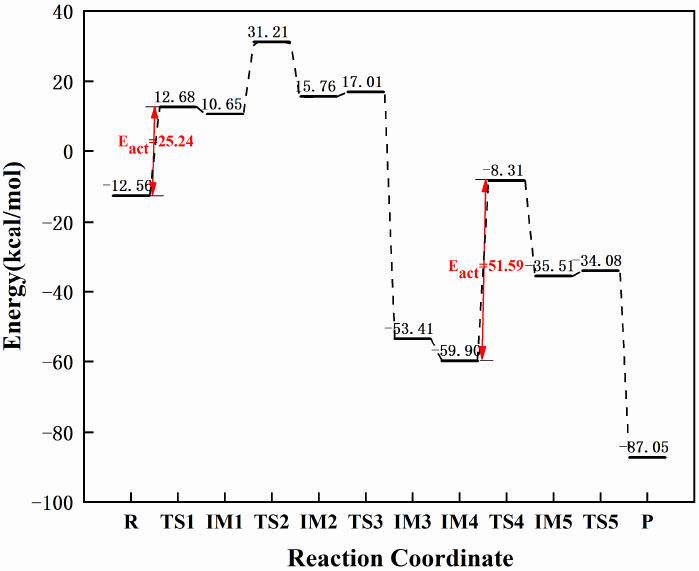
Figure 16. The most favorable energy path diagram for the hydrogenation of acetylene on graphene-NiN 4 .